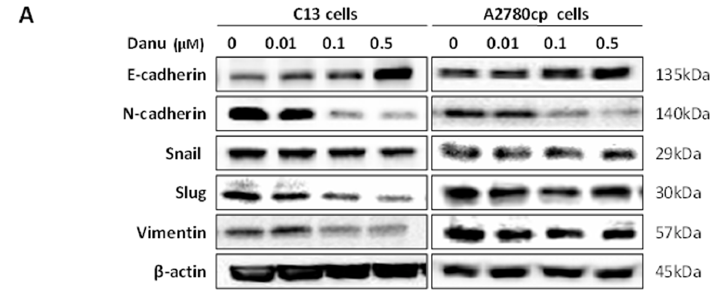
Figure 13. Cont. Figure 13. Cont .